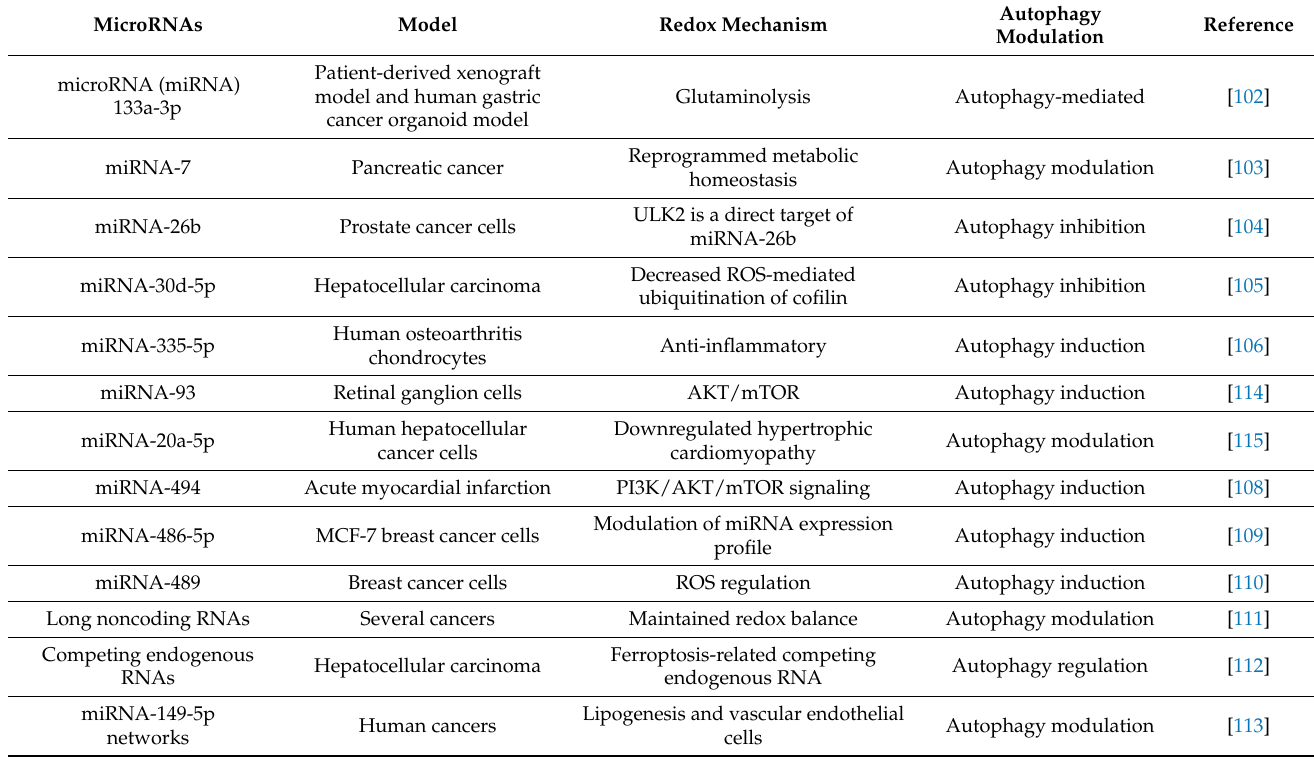
Table 4. Targeting redox metabolism and autophagy in different cancer cells through